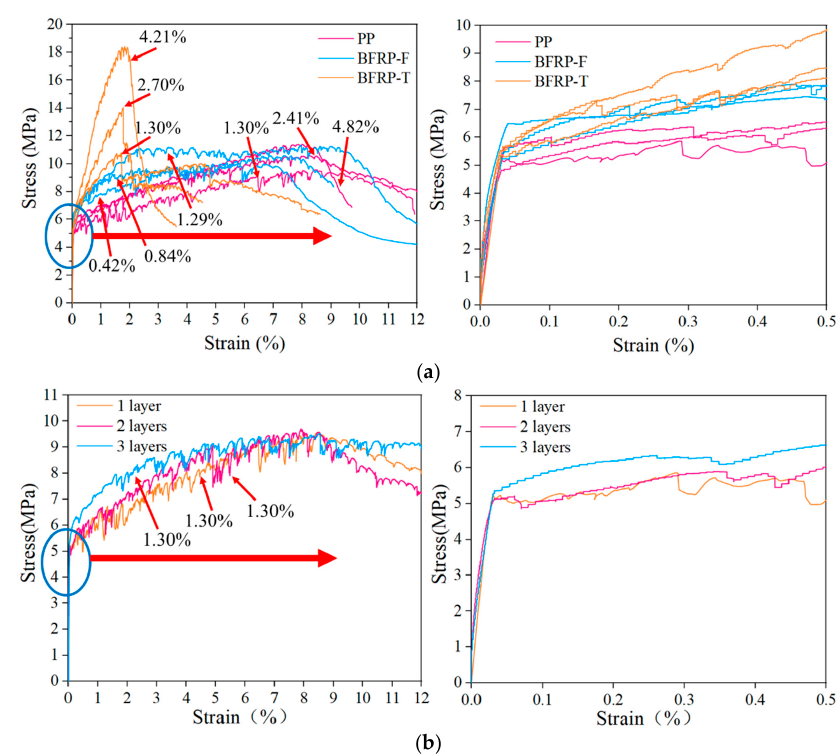
Figure 7. ( a ) Comparison of enhancement ratios of different reinforcement materials and ( b ) com- parison of arrangement